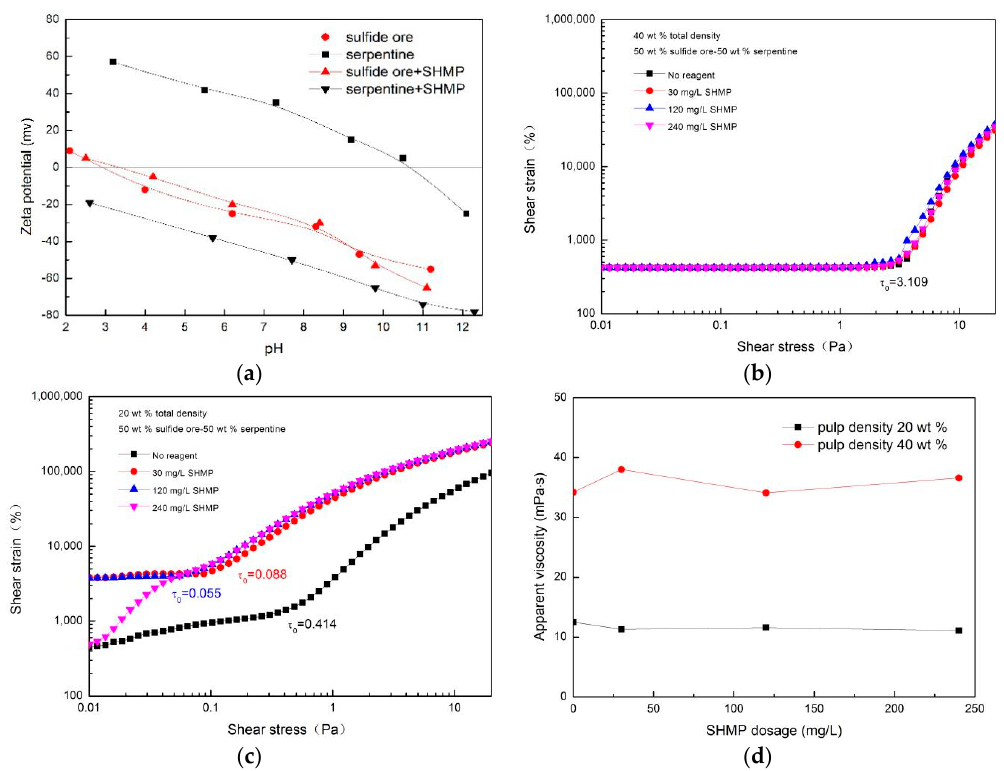
Figure 4. Effect of SHMP (sodium hexametaphosphate) on the: ( a ) Minerals zeta potential; ( b ) the shear strain values as a function of shear stress for the mixture of sulfide ore and serpentine at 40 wt %; ( c ) 20 wt % densities; and ( d ) their apparent viscosity with different depressant dosages at 100 s − 1 .